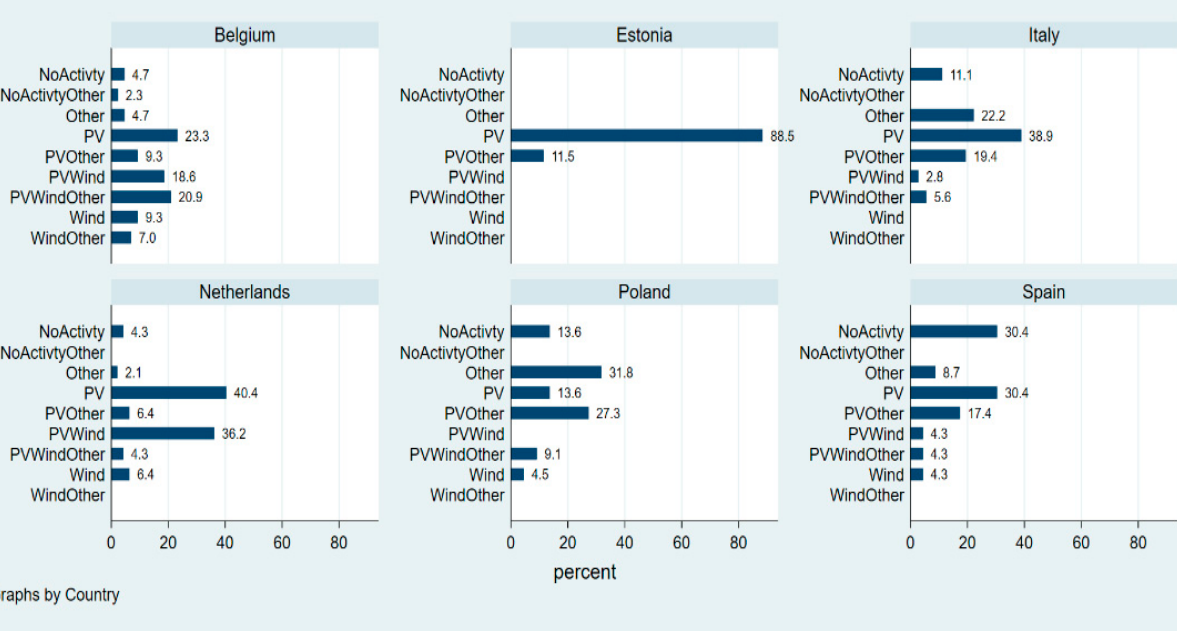
Figure A3. E-mobility Combinations, by country. Results in percentages. References 1.